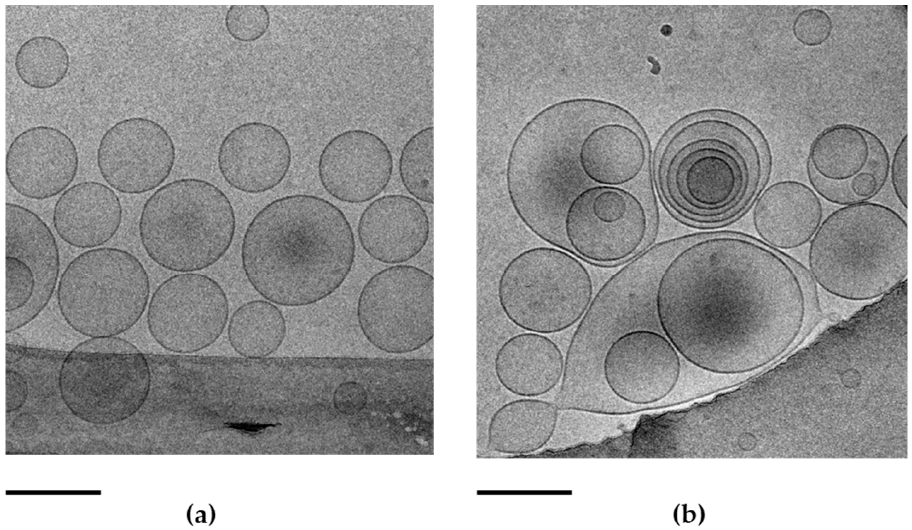
Figure 1. Cryo-TEM images of TET 0.9 -DMF 0.5 ( a ) and TET 2.7 -DMF 0.5 ( b ). The bar corresponds to 200 nm in both panels.